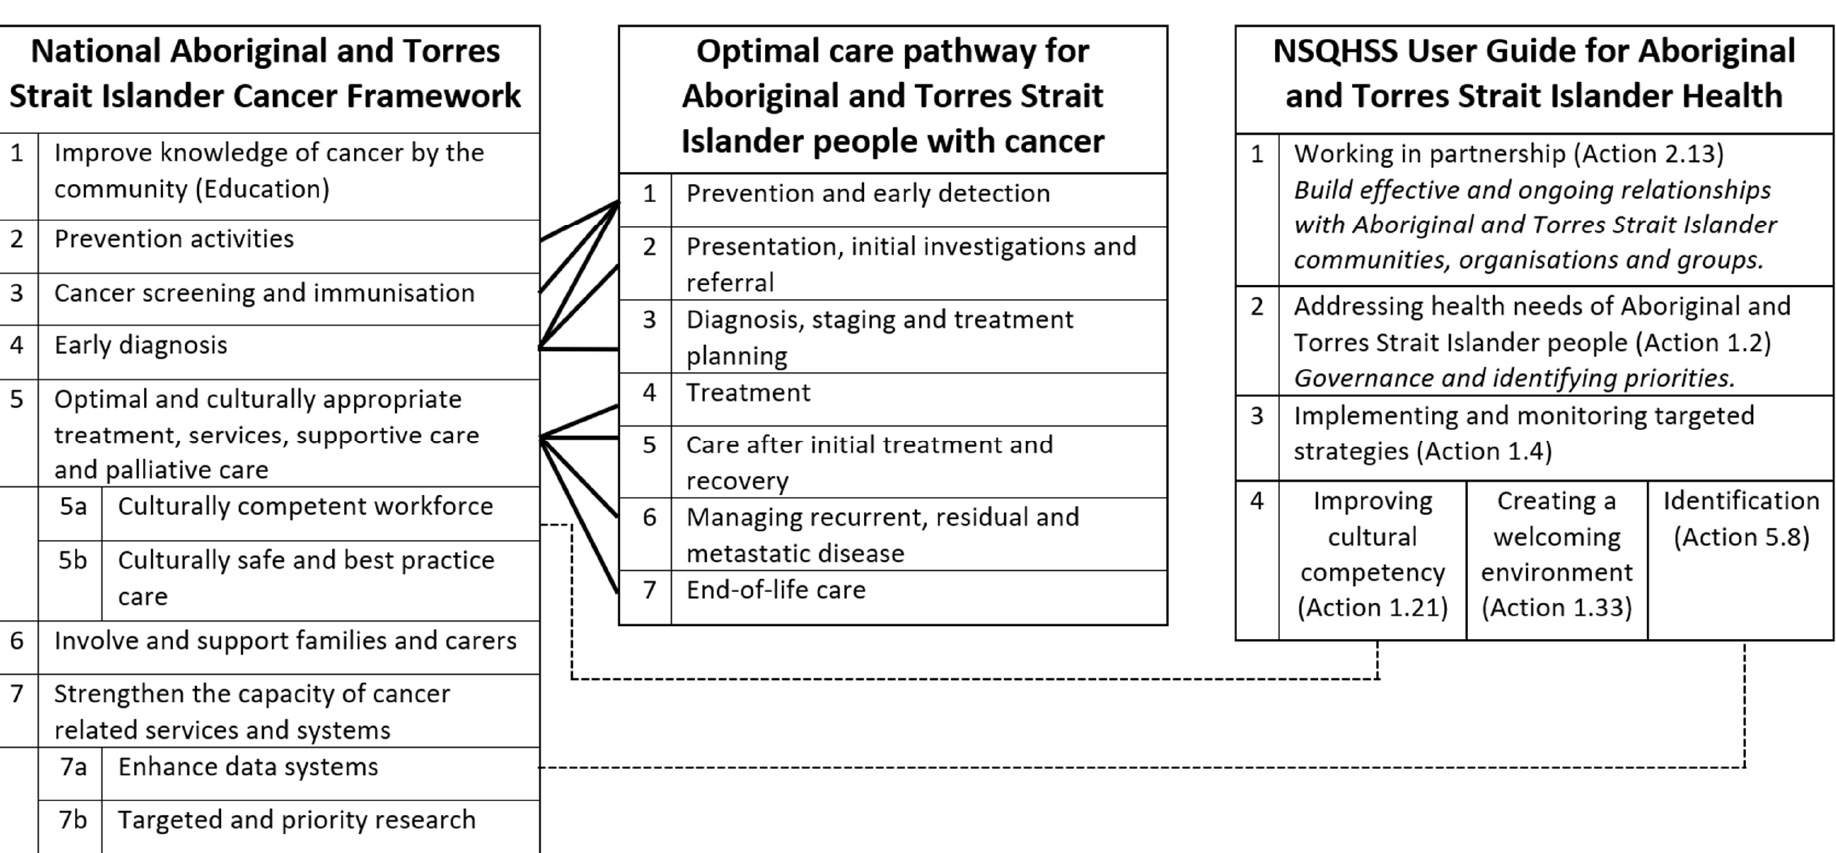
Figure 1. Overlap and inter-relation between the National Aboriginal and Torres Strait Islander Cancer Framework, the Optimal Care Pathway for Aboriginal and Torres Strait Islander People with Cancer and the NSQHSS User Guide for Aboriginal and Torres Strait Islander Health.